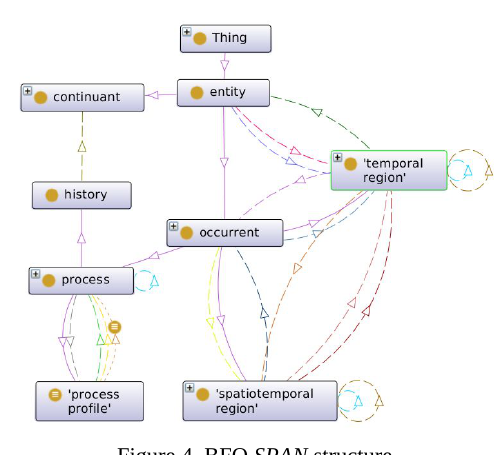
Figure 4. BFO SPAN structure